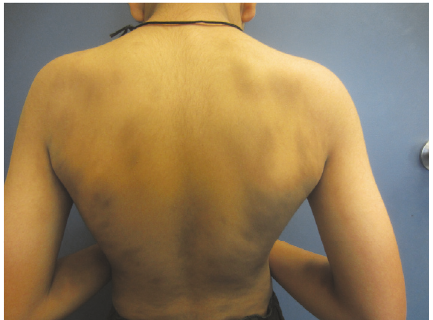
Figure 2: Well-demarcated oval ash-brown macules and patches symmetrically distributed over the upper back.